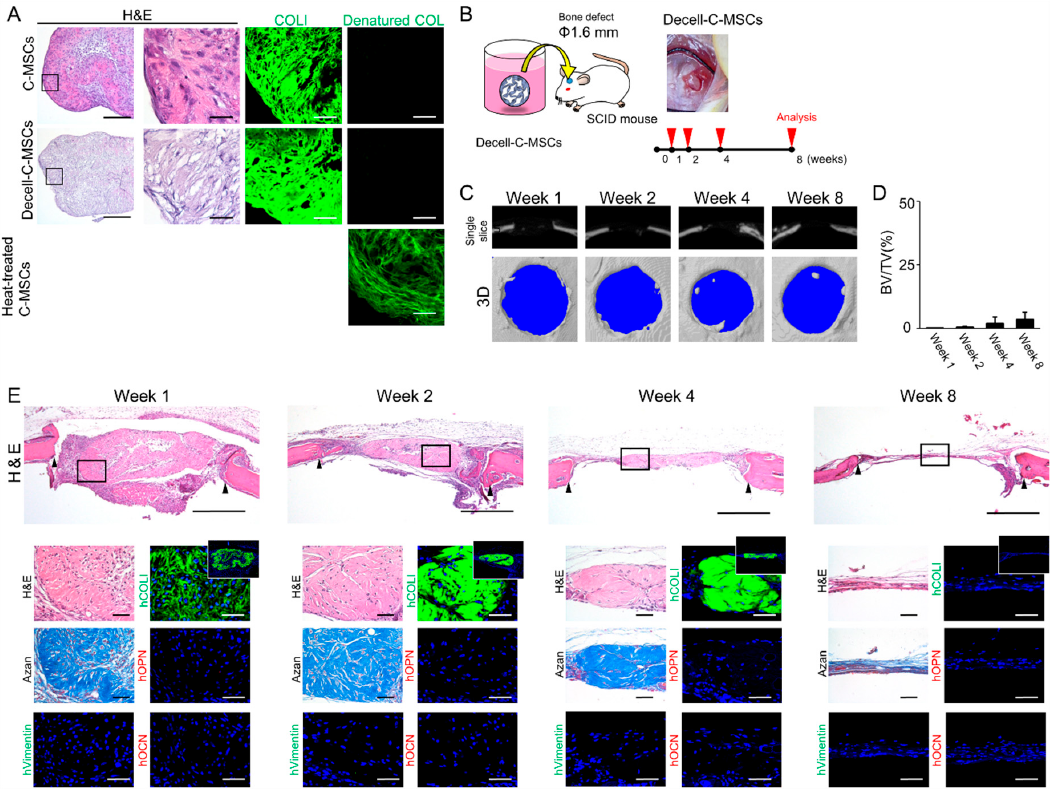
Figure 5. Transplantation of Decell-C-MSCs failed to induce bone regeneration. ( A ) C-MSCs, Decell-C-MSCs, and heat-treated C-MSCs were prepared as described in the Materials and Methods section. Semi-serial sections were stained with H&E and immunostained with anti-COLI antibody and 5-FAM conjugated-collagen hybridizing peptide, as indicated. Left panels show lower magnification. Bar = 200 µm. The second to fourth panels are magnifications of the boxed regions. Bar = 50 µm. ( B ) Study design for the in vivo experiment. Decell-C-MSCs were transplanted into a SCID mouse calvarial defect 1.6 mm in diameter with no artificial scaffold. ( C ) Representative µCT images at 1, 2, 4, and 8 weeks after surgery. ( D ) Ratio of the segmented bone volume (BV) to the total volume (TV) of the defect region at 1, 2, 4, and 8 weeks following surgery. Data are mean ± SD of four mice per group. ( E ) Animals were sacrificed at 1, 2, 4, and 8 weeks after surgery and the calvarial bones were fixed. Semi-serial sections were obtained and stained with H&E and AZAN and immunostained with anti-human vimentin, anti-human COLI, anti-human OPN, and anti-human OCN antibodies, as indicated. Nuclei were counterstained with DAPI for immunostaining. Upper panels show lower magnification. Bar = 200 µm. Bottom panels are magnifications of the boxed region. Bar = 50 µm. White boxes indicate human COL1 expression in the whole defect area. The photographs are